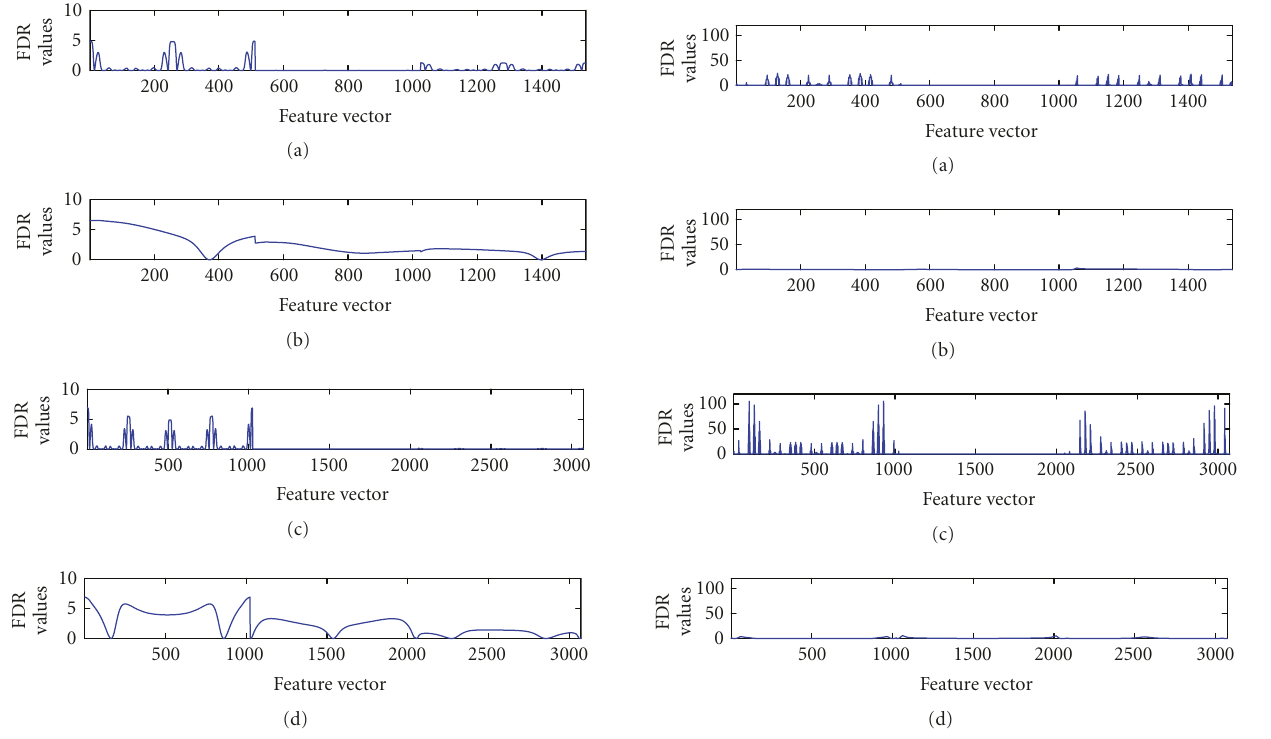
Figure 13: FDR values related to (a) (cid:9) c u , (b) (cid:9) c u , (c) (cid:21) c h , and (d) (cid:21) c h or or feature vectors when the disturbance is